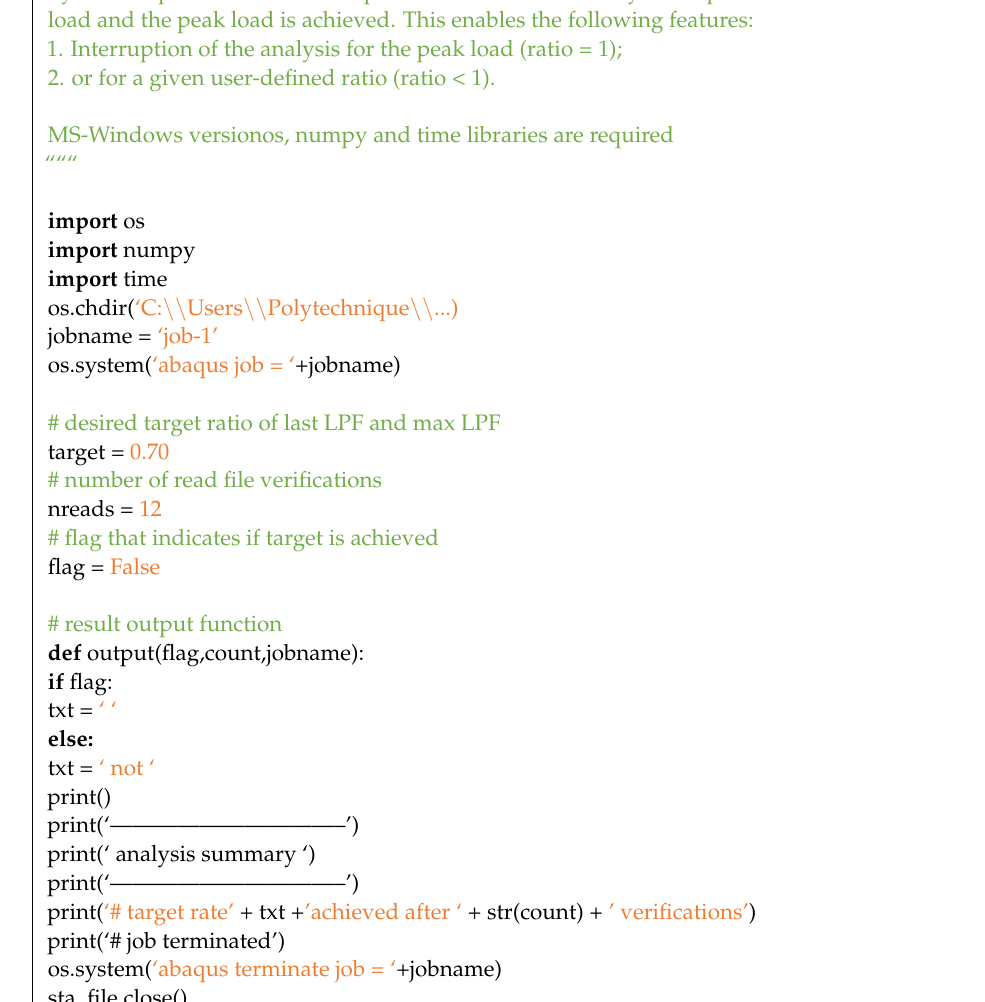
Algorithm 1. Python script that establishes OS shell communication with Abaqus and